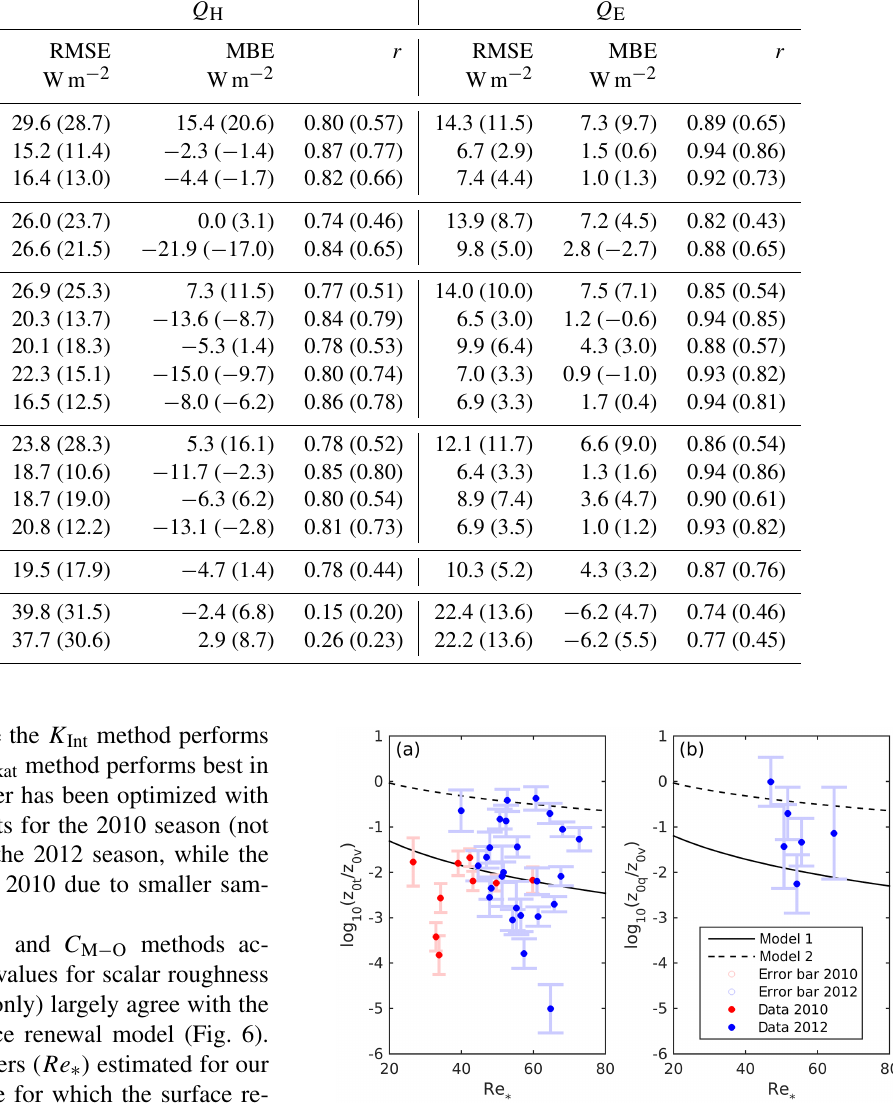
Figure 6. (a) Ratio of roughness lengths for temperature ( z 0 t ) and momentum ( z 0 v ) vs. roughness Reynolds number ( Re ∗ ), and (b) ra- tio of roughness lengths for humidity ( z 0 q ) and z 0 v vs. Re ∗ . Model 1 (solid line) is the theoretical prediction of Andreas (1987), and model 2 (dashed line) is the prediction of Smeets and van den Broeke (2008). Mean log value of z 0 v specific to each season (Ta- ble 1) is used to calculate Re ∗